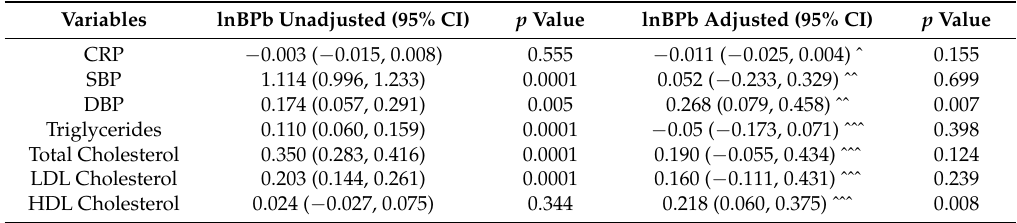
Table 2. Associations of BLL with Cardiovascular-Related Markers of Interest.